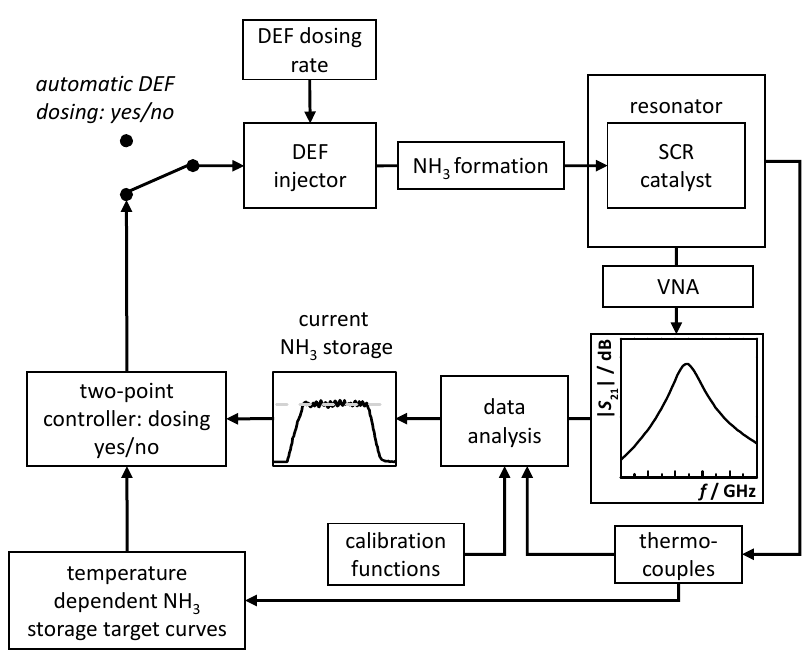
Figure 4. Control flow diagram of the applied RF-controlled and temperature-compensated NH 3 storage determination and urea dosing system.